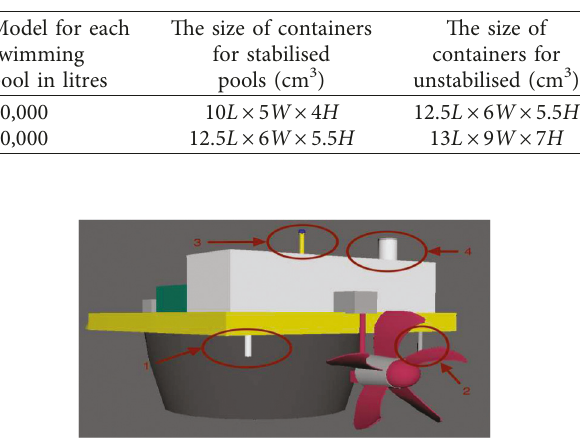
Figure 14: An alternative design of swimming pool treatment boat